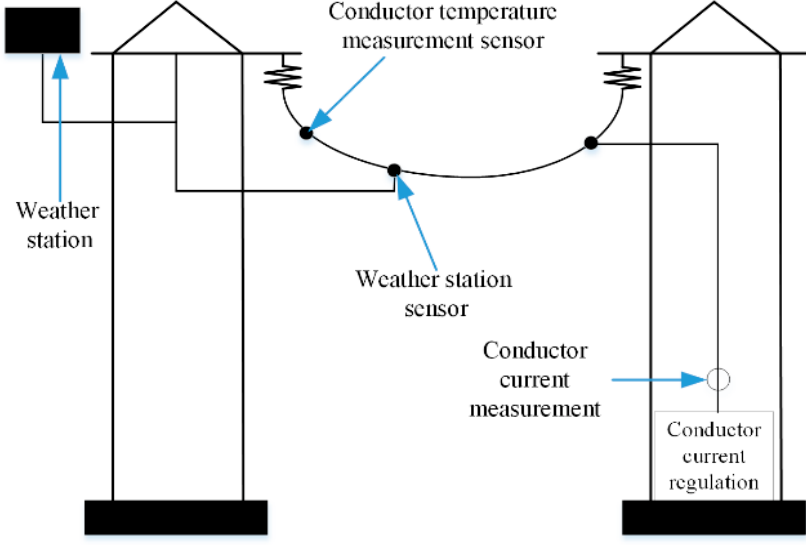
Figure 3. Schematic presentation of the testing site.